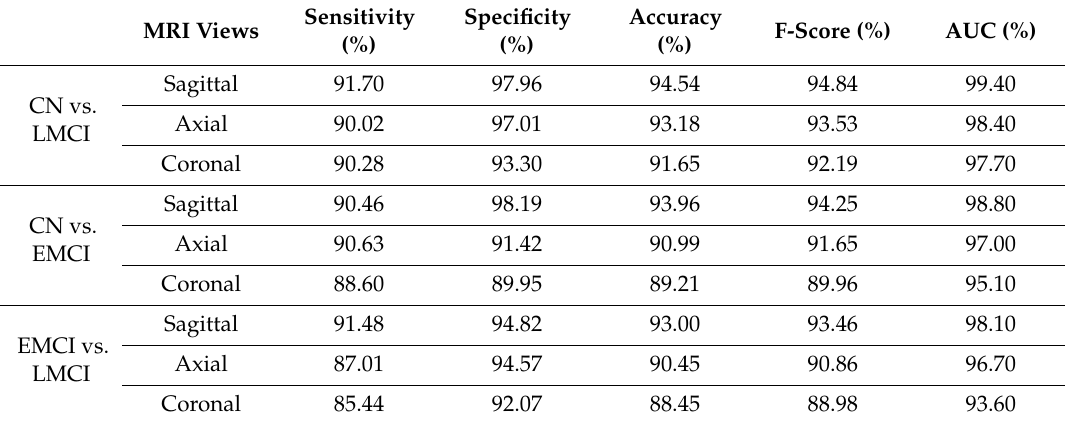
Table 2. The classification results of the control normal (CN) versus early mild cognitive